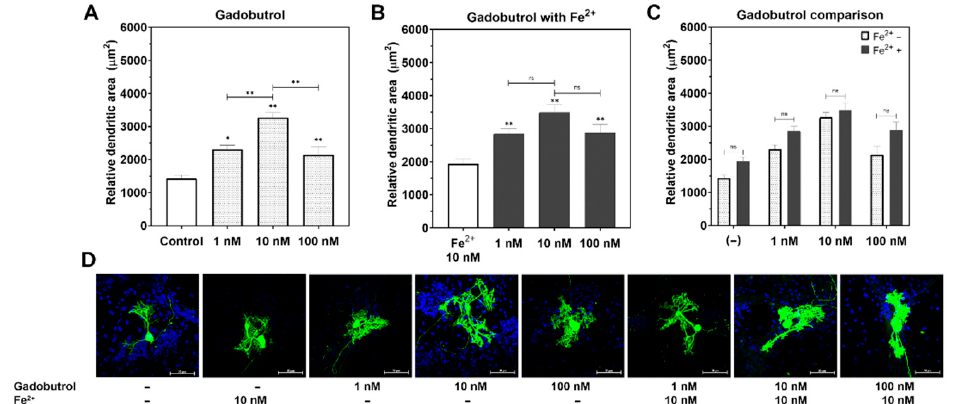
Figure 3. Changes in the relative dendritic area of the Purkinje cells post incubation with gadobutrol with/without Fe 2+ . ( A ) Representative photomicrograph of gadobutrol-treated Purkinje cells. ( B ) Incubation with gadobutrol significantly increased the Purkinje cell dendrite arborization compared to the control group, especially at 10 nM. ( C ) Fe 2+ did not increase the effect of gadobutrol on dendrite arborization. ( D ) The relative dendritic area of Fe 2+ + gadobutrol-treated cells was similar to that of the gadobutrol-treated cells. ** p < 0.01 and * p < 0.05 indicate a statistical significance by Tukey’s HSD post-hoc test compared to the control group, unless indicated with a significance bar. ns: not